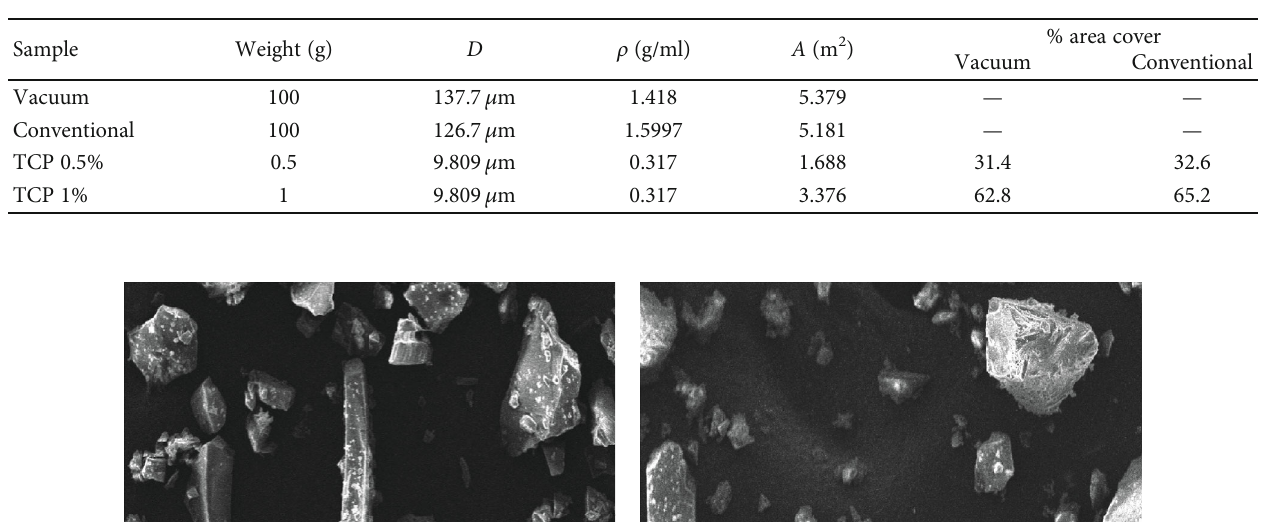
Figure 5: Distribution particle size of (a) conventional and vacuum-dried coconut sugar powder and (b) tricalcium phosphate. Table 2: The hypothetical area of coconut sugar powder produced by vacuum drying and conventional method and tricalcium phosphate (TCP).